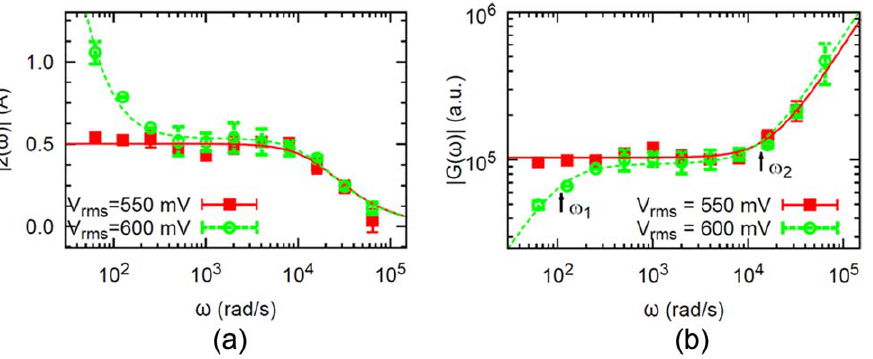
Figure 2. AC susceptibility of GK (from [ 14 ] ). (a) Amplitude of the protein deformation vs frequency for two different amplitudes of the force (corresponding to driving voltages 550 and 600 mV). (b) Magnitude of the complex modulus G v ð Þj j (arbitrary units) of the protein + GNP system; this is the same data as in (a) replotted as 1 = z j j vs v . For V rms ~ 550 mV (squares) the behavior is elastic; for V rms ~ 600 mV (circles) the behavior is viscoelastic. The error bars represent standard deviations of 5 measurements. The real ‘‘complex modulus’’ corresponding to 1 | 10 5 in the graph is * 5 pN/nm. The points are experimental data while the lines are fits with the corresponding elastic or viscoelastic models.